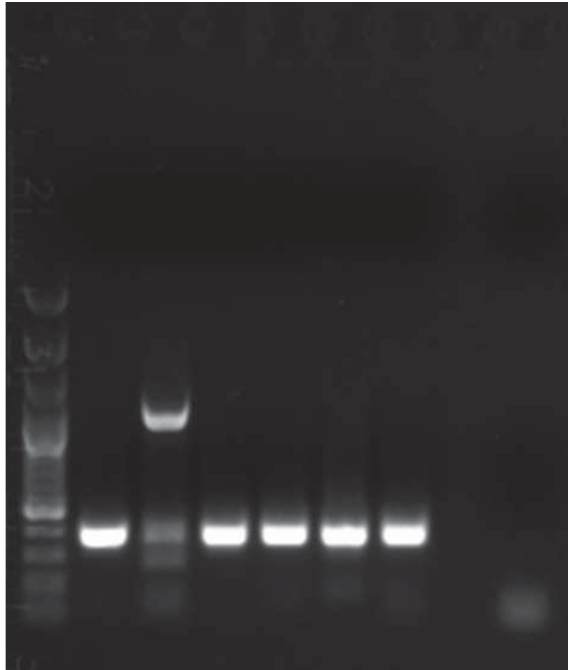
Figure 1- Results of positive control reactions for the correct DNA isolation from oral caves - beta actin gene. Description of results: 1- Gene Ruler 100 bp Ladder